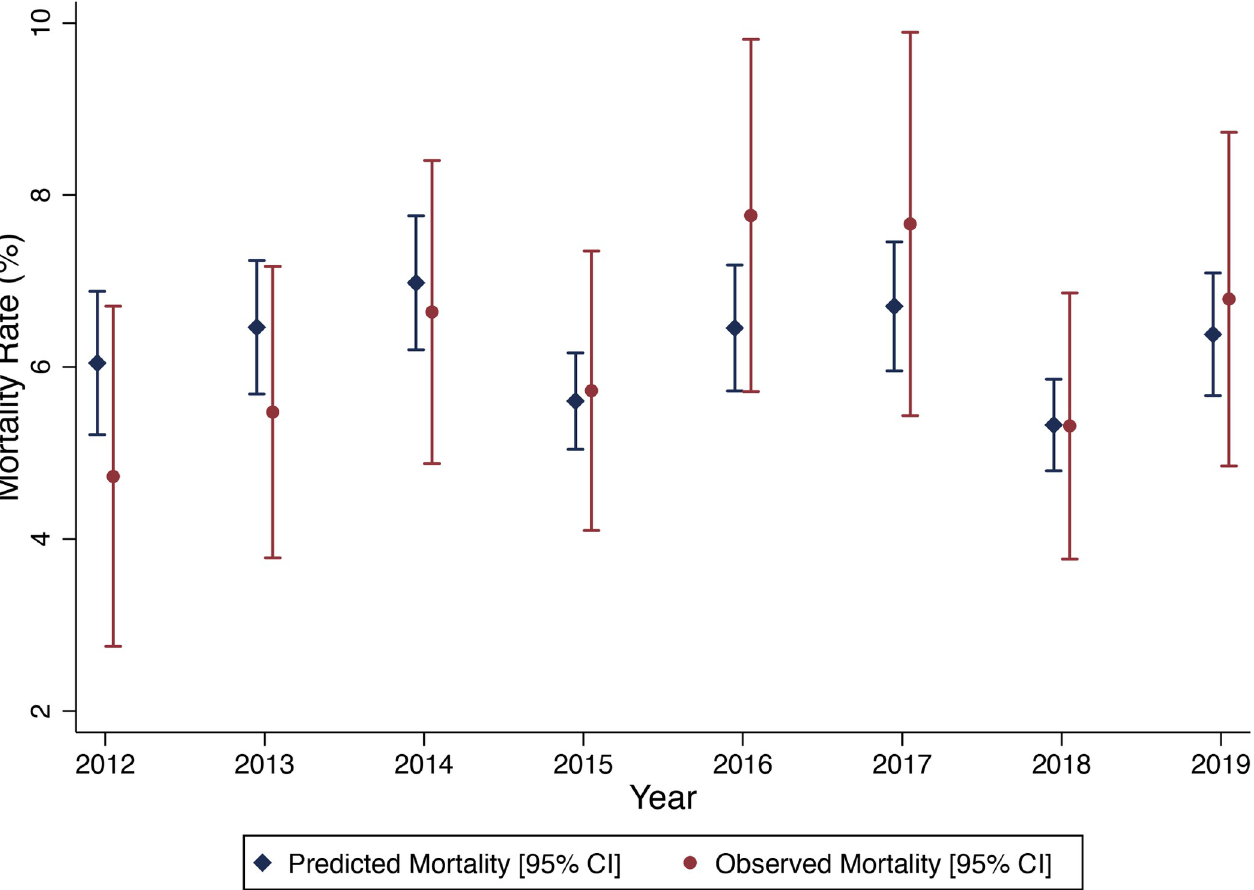
Fig 5. Annual predicted and observed mortality in septic (qSOFA � 1) patients without malaria,